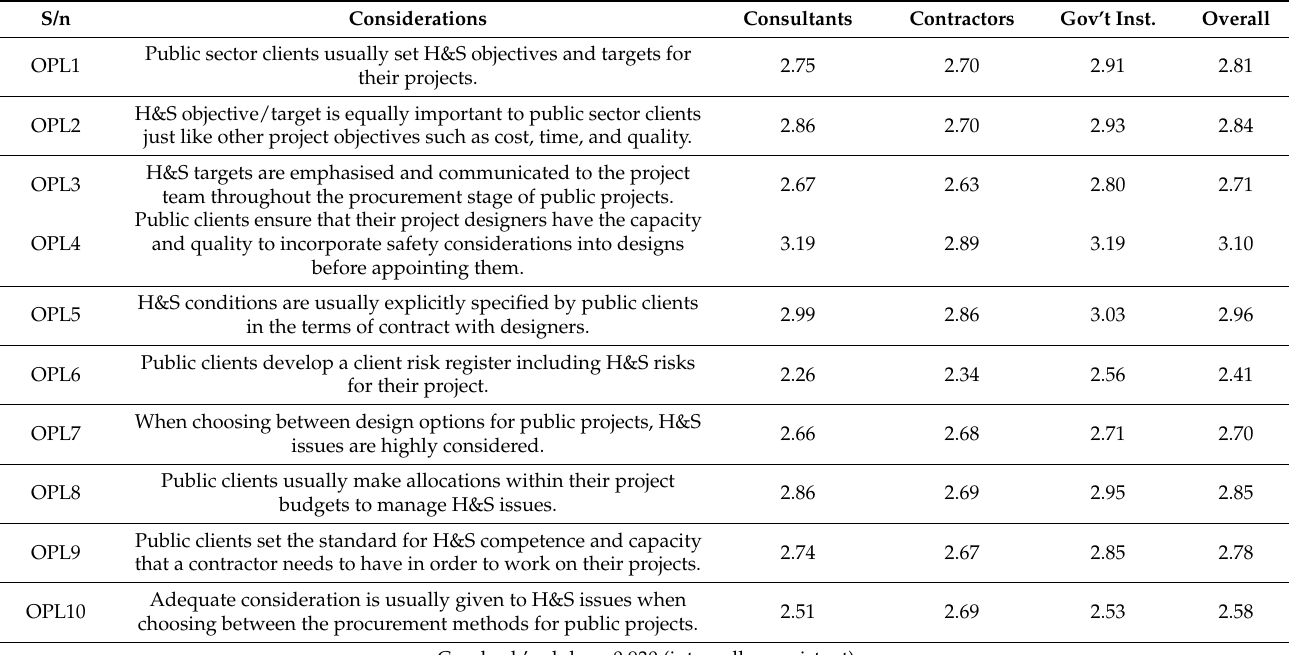
Table 2. Health and safety (H&S) considerations at the planning stage of public projects. Consultants Contractors Gov’t Inst. Overall